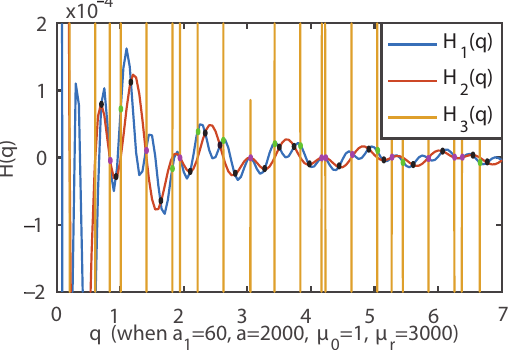
Figure 5. Changes of the eigenvalues for Q x when µ x change.